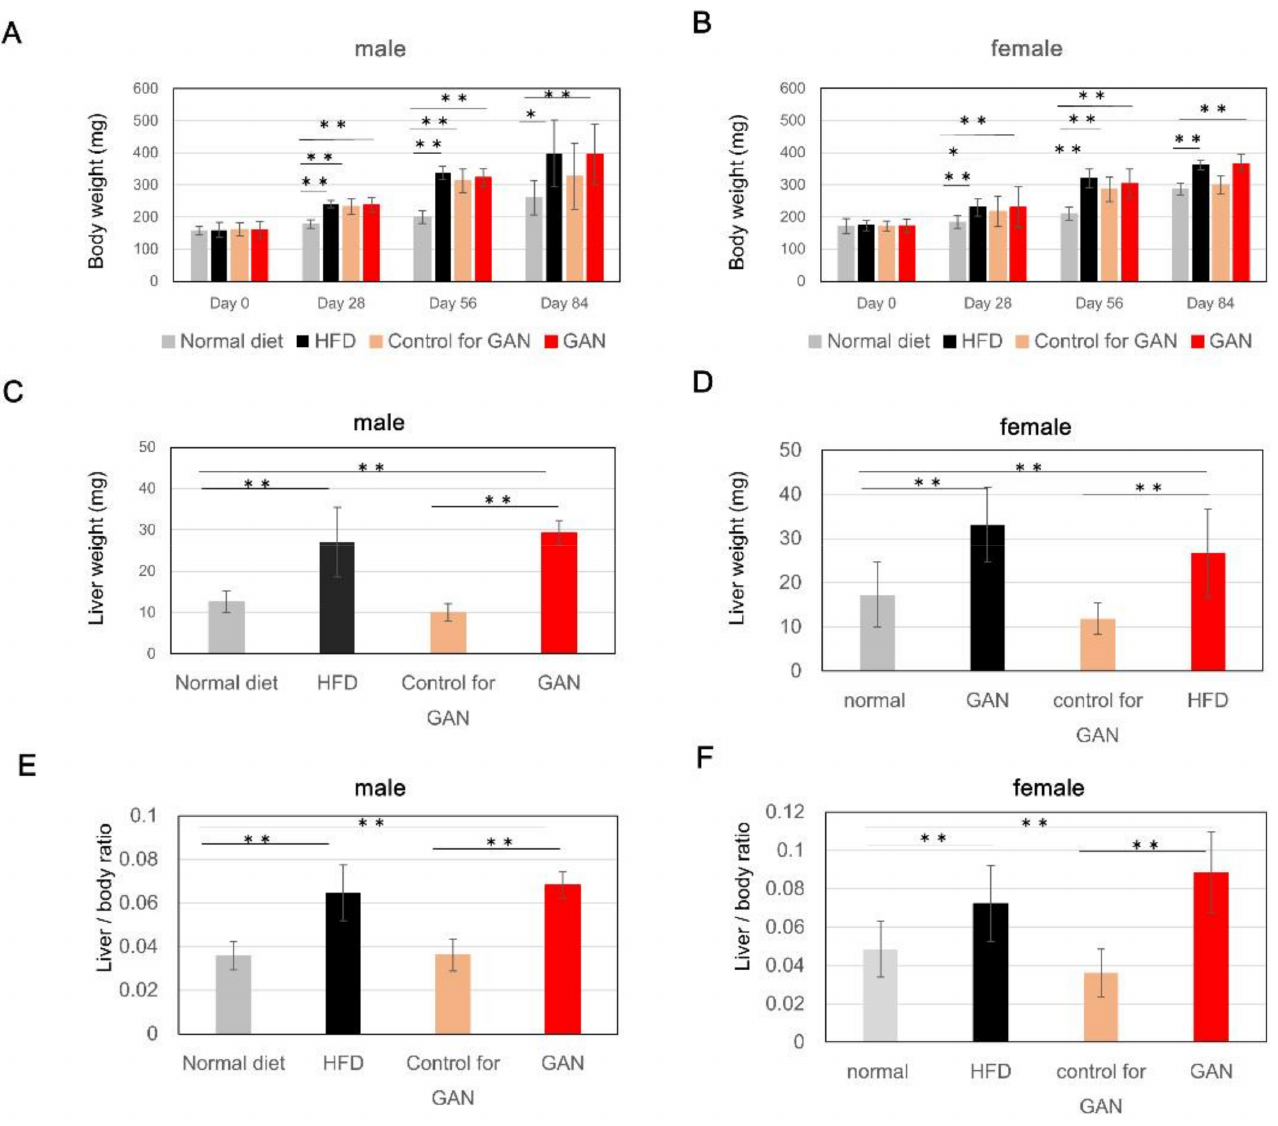
Figure 1. Body weight, weight of liver, and liver–weight ratio after administration of each diet. ( A , B ) Changes in body weight after administration of each feed; ( C , D ) Weight of liver three months after administration of each diet; ( E , F ) Liver– weight ratio three months after administration of each diet; Data are represented as the mean ± standard deviation (SD) ( n = 10); * indicates significant difference ( p < 0.05), ** indicates significant difference ( p <